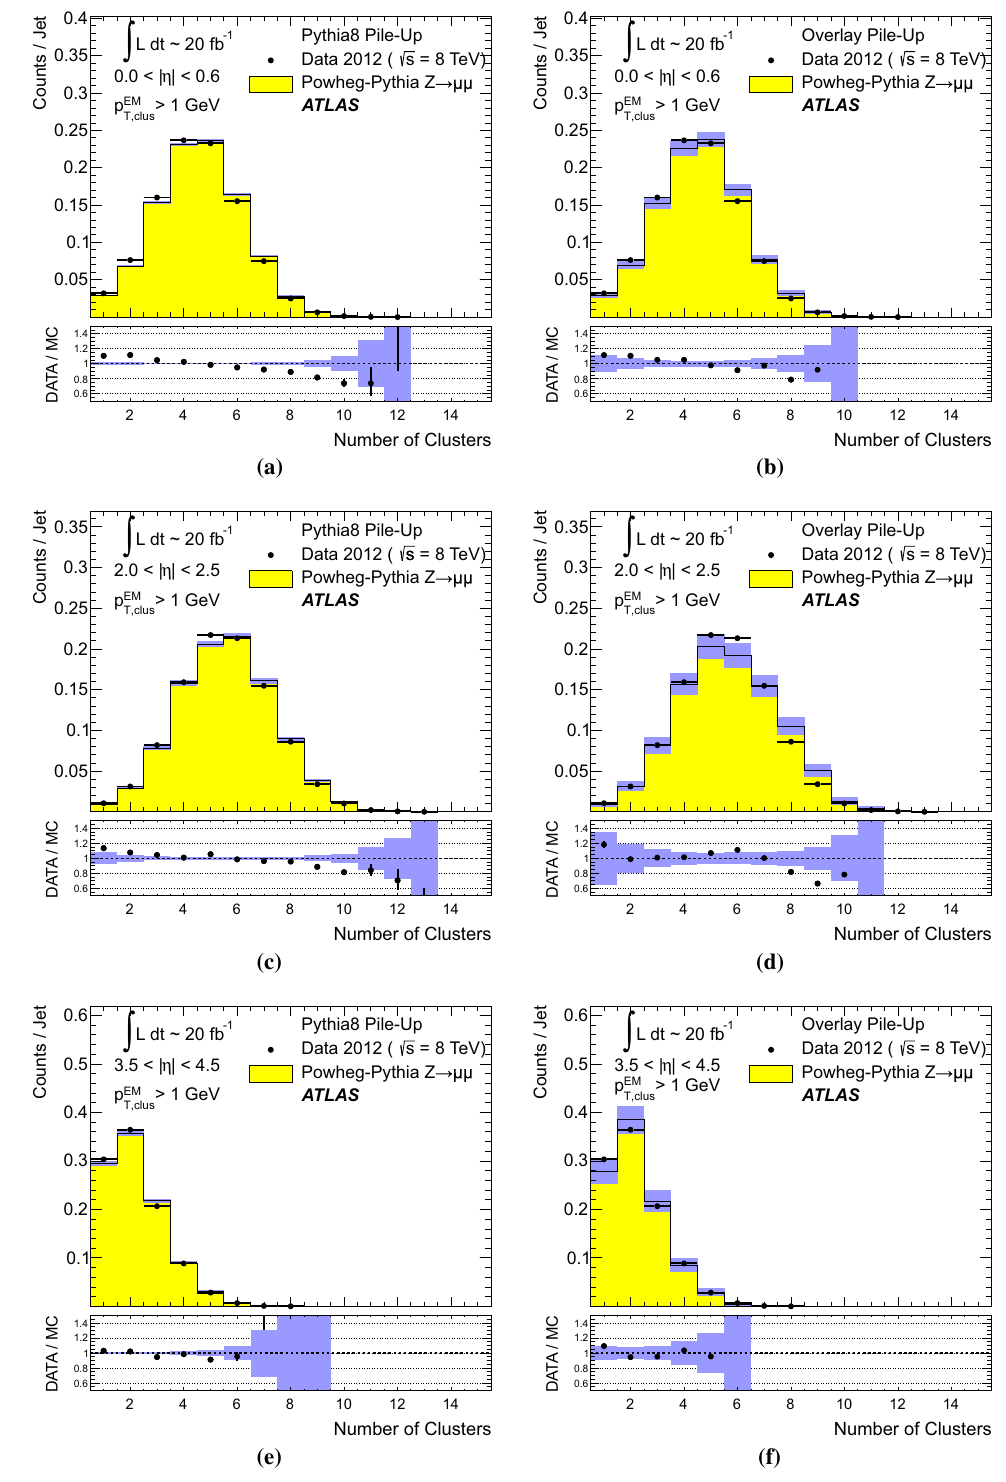
> and e , and with pile-up from data overlaid in b , d and f . The data-to- T , clus MC simulation ratios are shown below the respective distributions. The shaded bands indicate statistical uncertainties for the distributions from MC simulations and the corresponding statistical uncertainty bands for the